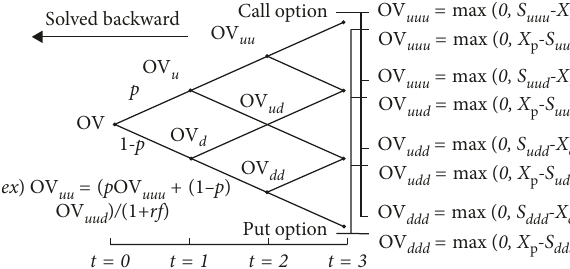
Figure 5: Binomial tree for solving the option value (backward process).